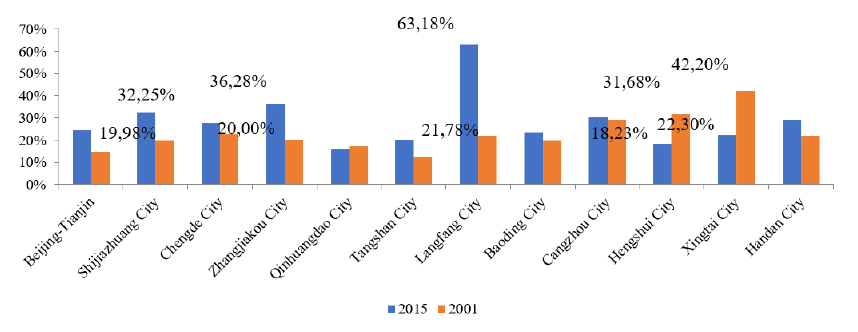
Fig. 2 Composite index coefficients of variation for cities in the Beijing-Tianjin-Hebei